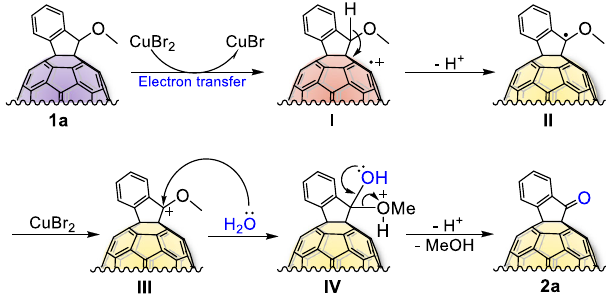
Fig. 5 Proposed mechanism. Plausible mechanism for CuBr 2 -promoted one-step direct oxidation of alkoxy group to ketone.